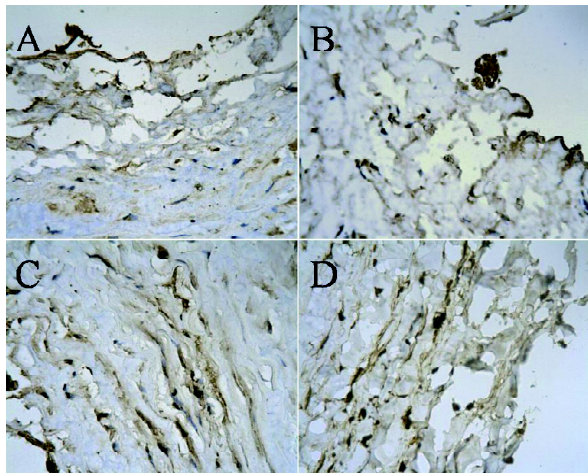
Fig. 9 - In the aortic intima, there was significant structural disruption in patients with aortic dissection (A), aortic aneurysm (B) or coronary heart disease (C), associated with decreased expressions of osteopontin in comparison to healthy control (D). The intense of the expressions in a descending order was healthy control > coronary heart disease > aortic aneurysm > aortic dissection. Envision×400